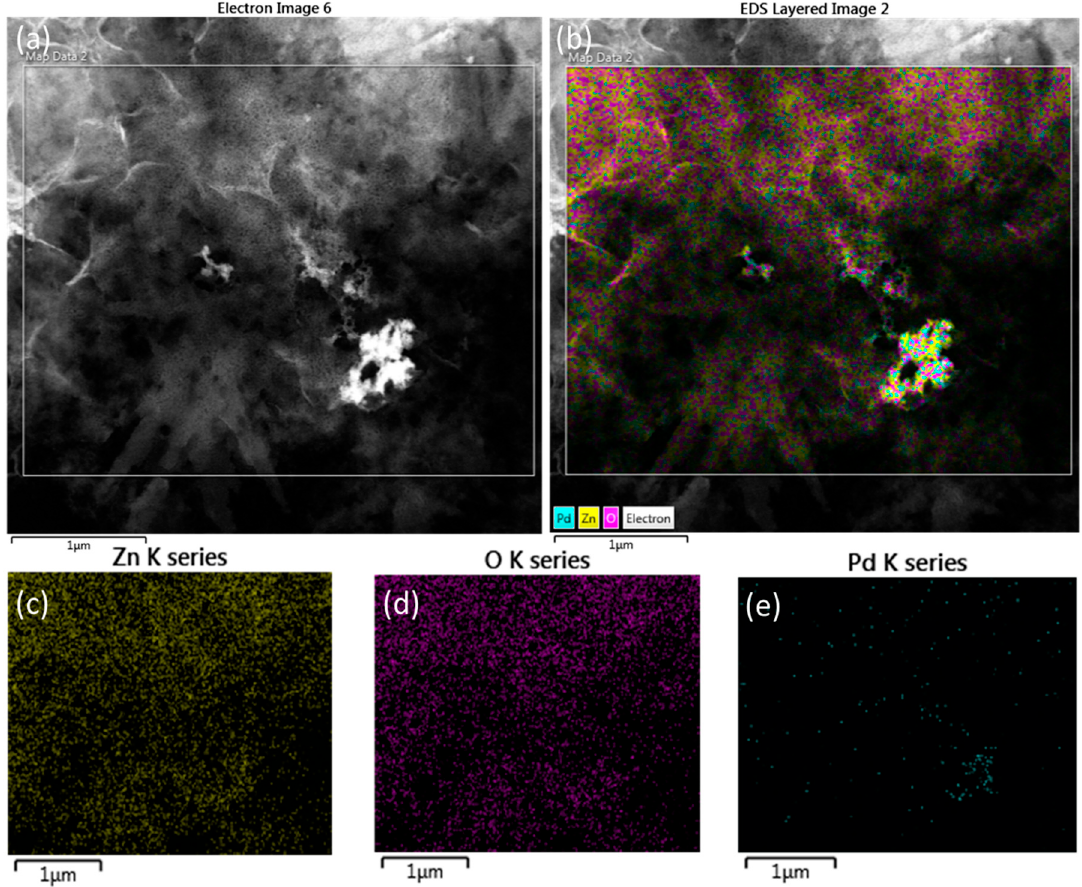
Figure 4. EDX mapping of biosynthesized ZnO-Pd nanosheets. ( a ) Area selected in the TEM image for the elemental mapping. ( b ) Distribution of Zn, O, and Pd elements. ( c ) Zn–K map (yellow). ( d) O-K map (magenta). ( e ) Pd-K map (blue).